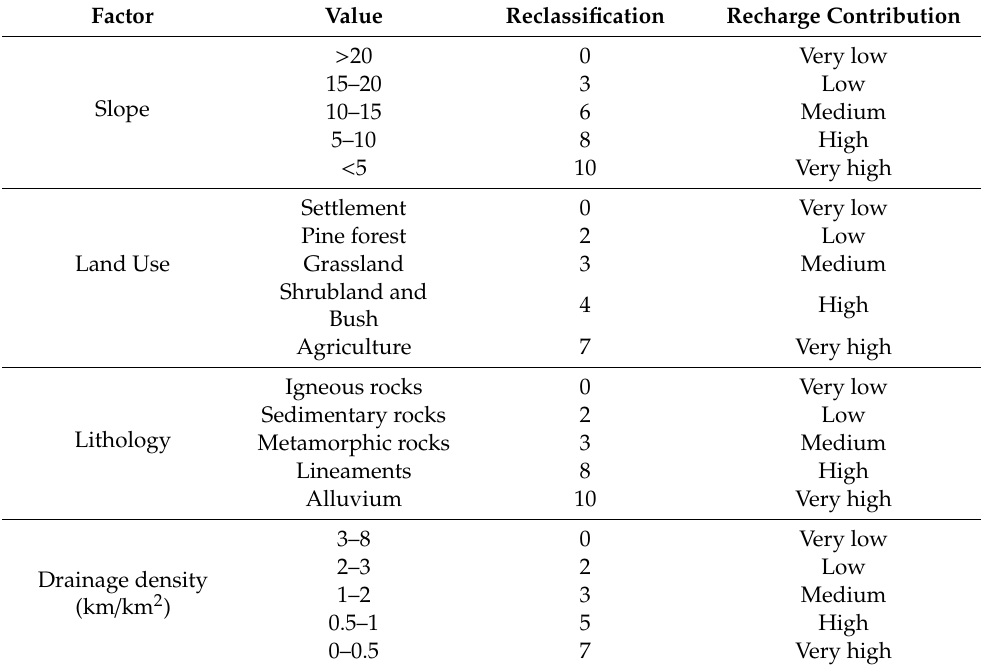
Table 1. Reclassification and recharge contribution of the influencing factors.